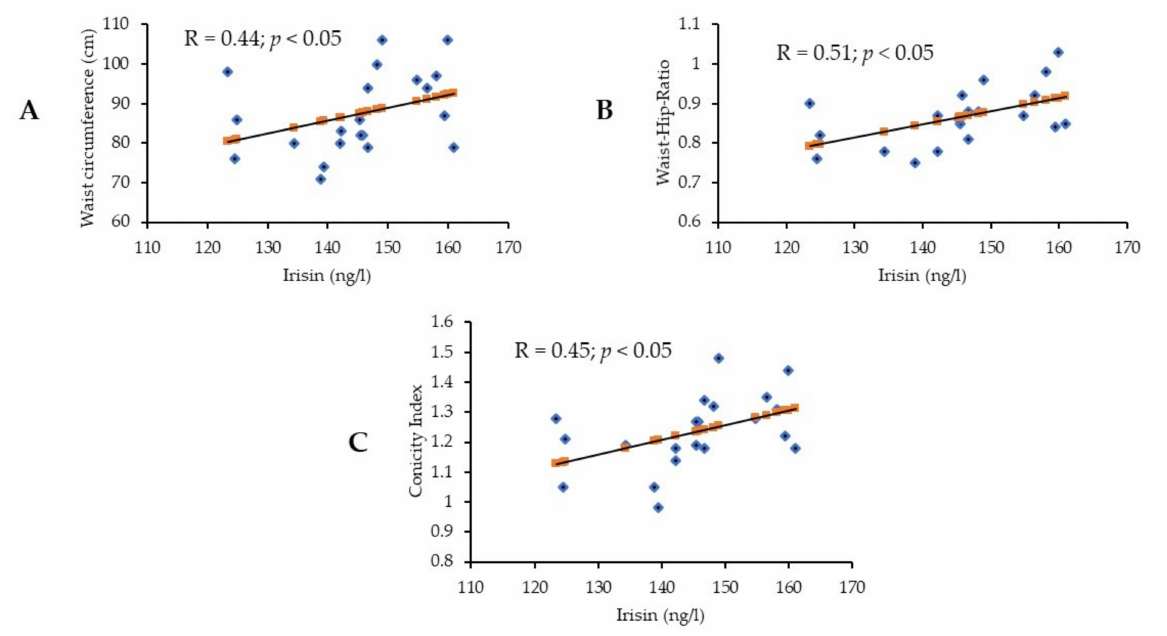
Figure 1. Significant positive associations of irisin with ( A ) waist circumference, ( B ) waist to hip ratio, and ( C ) conicity index in the sarcopenia